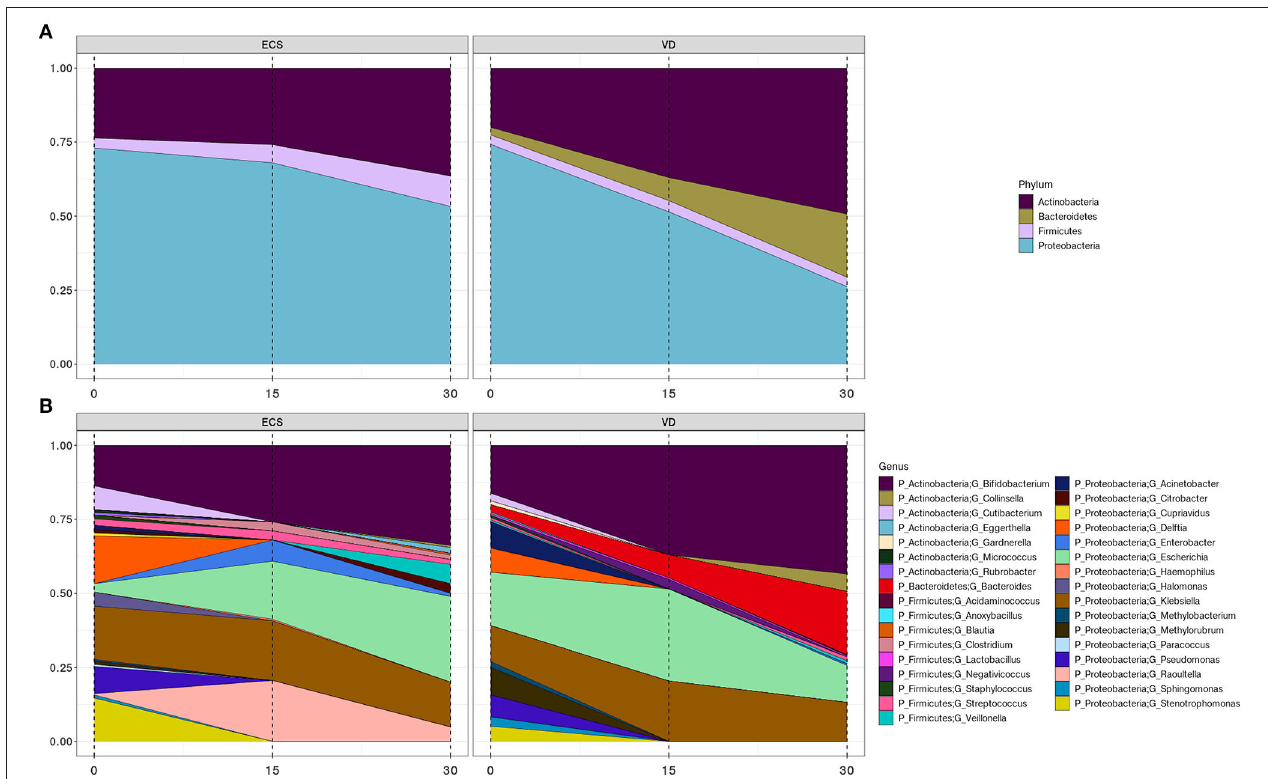
FIGURE 3 | Development trajectory of the newborn’s gut microbiota according to DM. Area plots showing the longitudinal changes of > 2% relative abundance across all samples of bacterial phyla (A) and their corresponding genera (B) in elective cesarean section (ECS) and vaginally delivered